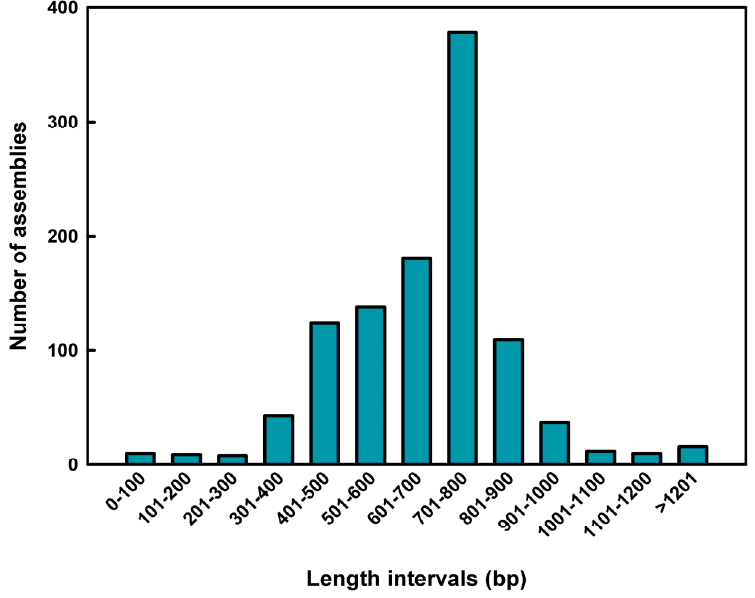
Figure 1. Length distribution of insert sequences of plasmid clones. Sequencing of the 672 randomly selected clones generated 1075 assemblies (126 contigs, 949 singlets). The x -axis indicates the length interval of insert sequences. The y -axis indicates the number of assemblies at each length interval.